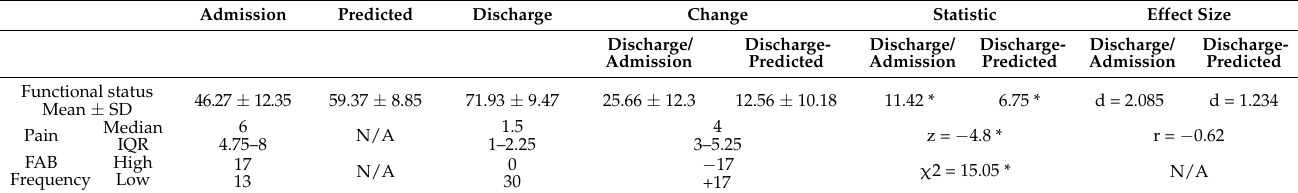
Table 4. Summary of the quantitative analysis ( n =